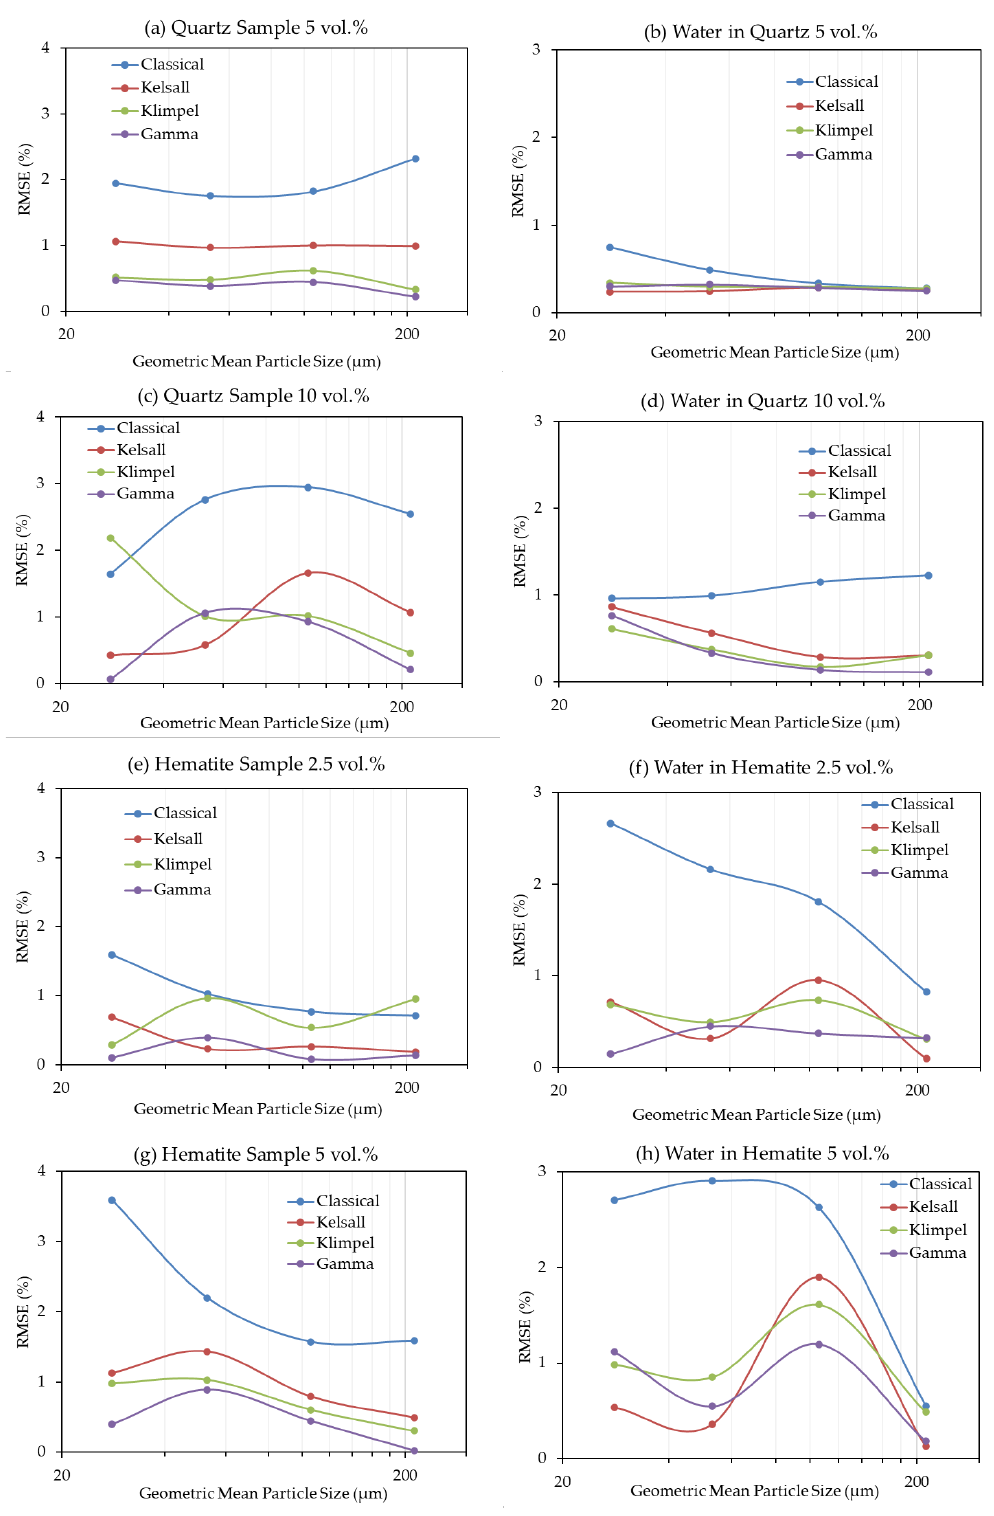
Figure 4. RMSE as a result of model fitting for the different methods in all experiments. ( a ) Quartz flotation recovery at 5 vol.%, ( b ) water recovery in quartz flotation at 5 vol.%, ( c ) quartz flotation recovery at 10 vol.%, ( d ) water recovery in quartz flotation at 10 vol.%, ( e ) hematite flotation recovery at 2.5 vol.%, ( f ) water recovery in hematite flotation at 2.5 vol.%, ( g ) hematite flotation recovery at 5 vol.%, ( h ) water recovery in hematite flotation at 5